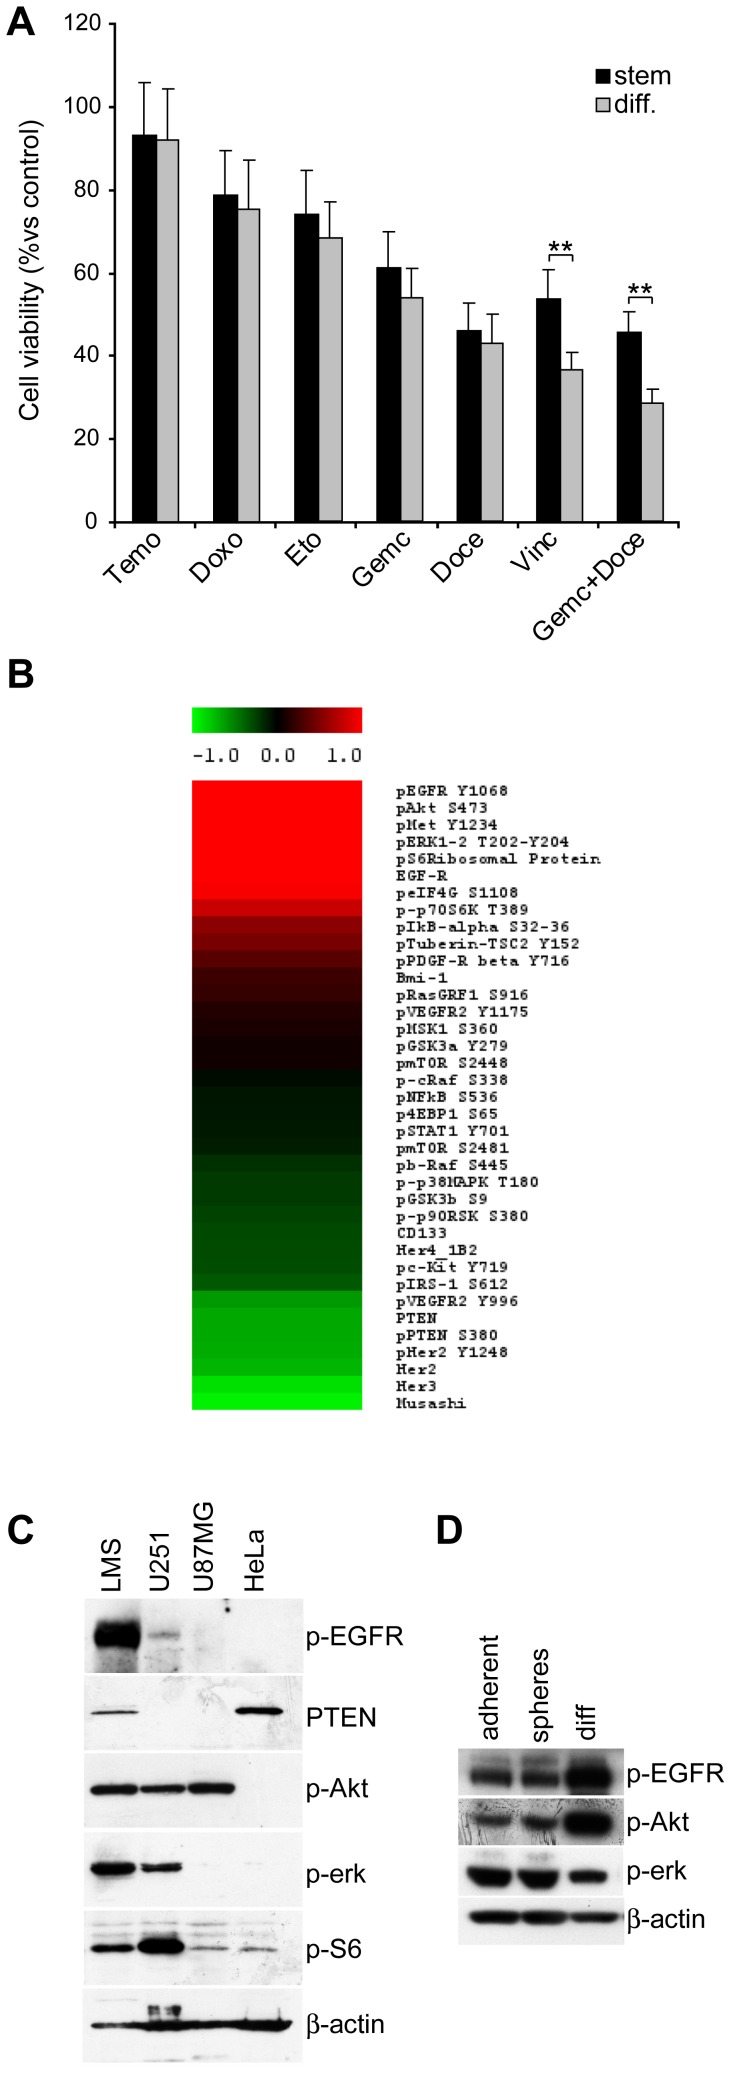
LMS stem-like cells are chemoresistant and display high activation of Akt and Erk pathways.A) Cell viability (% vs control, measured by cell titer glo luminescence) of undifferentiated and differentiated LMS cells exposed for 3 days to the indicated drugs. Mean ± SD of 3 independent experiments is shown. ** p<0,01. B) Reverse Phase Phosphoproteomic Array (RPPA) of LMS CSC. Standardized levels of expression or phosphorylation of the indicated proteins are reported. Standardized values were calculated for each antibody by subtracting the mean and dividing by the standard deviation of the sample series. Color scale limits from red to green include values spanning from ≥1,5 to ≤−1,5 standard deviations. C) Immunoblot analysis for the indicated proteins in LMS stem-like or control (U251, U87MG, HeLa) cells. D) Immunoblot analysis for the indicated proteins in LMS-stem like (adherent cultures or spheres) or differentiated (diff) cells.